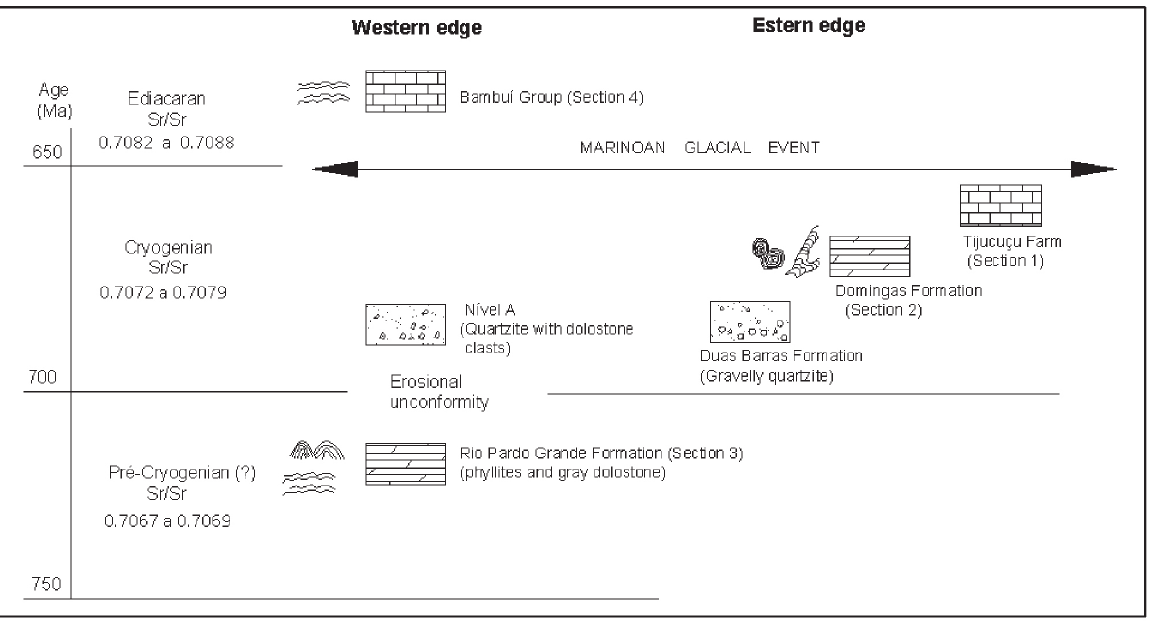
Figure 13 - Correlation between the different lithological units chemostratigraphic data observed in the Espinhaço Ridge sections in this study. Relationship between ages and 87 Sr/ 86 Sr composition were obtained in Halverson et al.